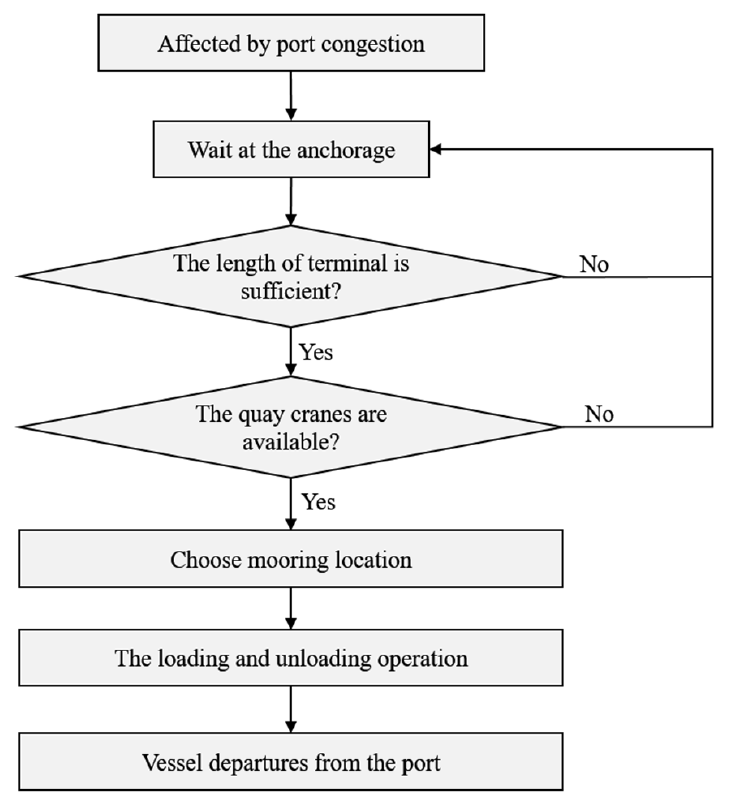
5 of 17 Figure 1. Two-dimensional diagram of integrated BACAP for continuous berth layout.